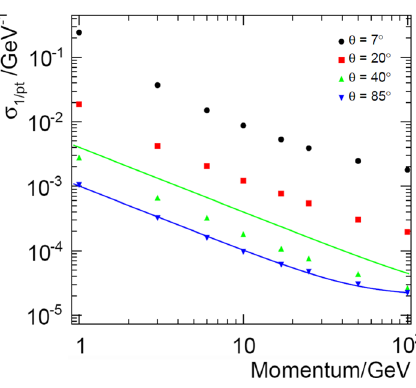
Fig. 2 The jet energy resolution as a function of | cos θ thrust | . Taken from Ref. [32]